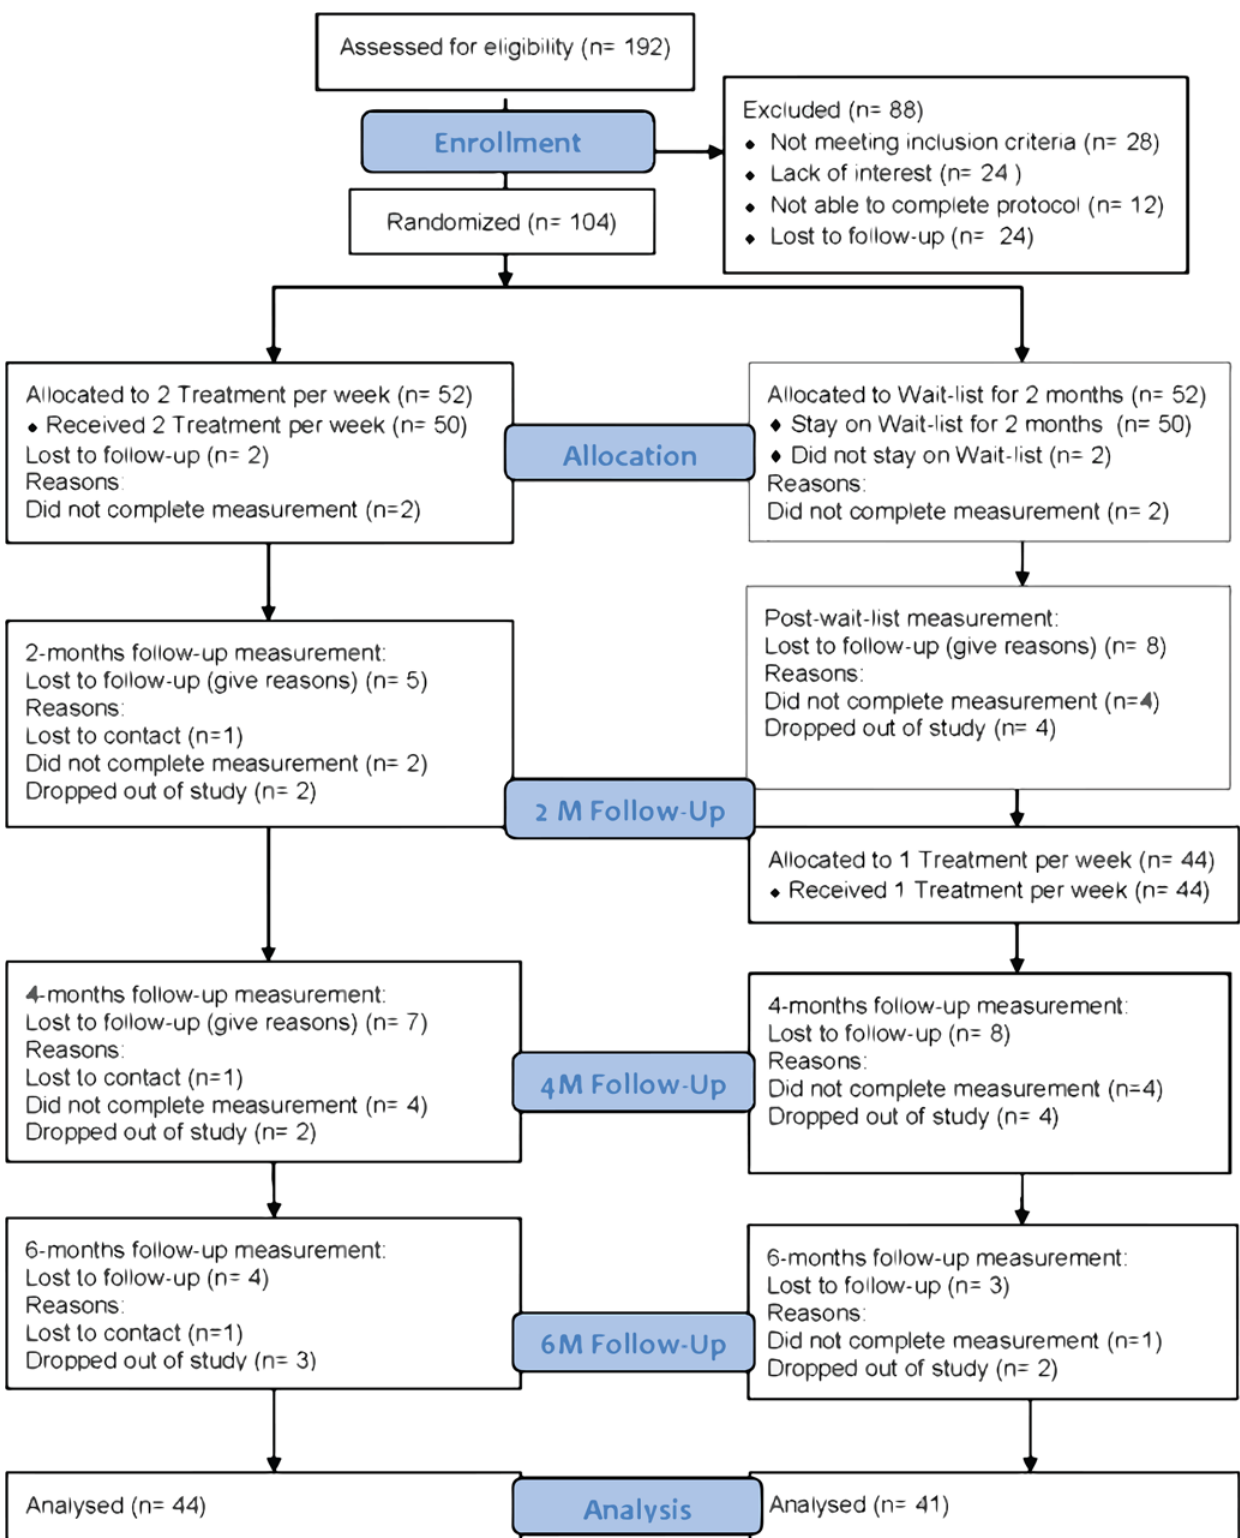
Fig 1. PLOS CONSORT Flow Diagram: Diagram of Screening, Randomization, and Follow-up.